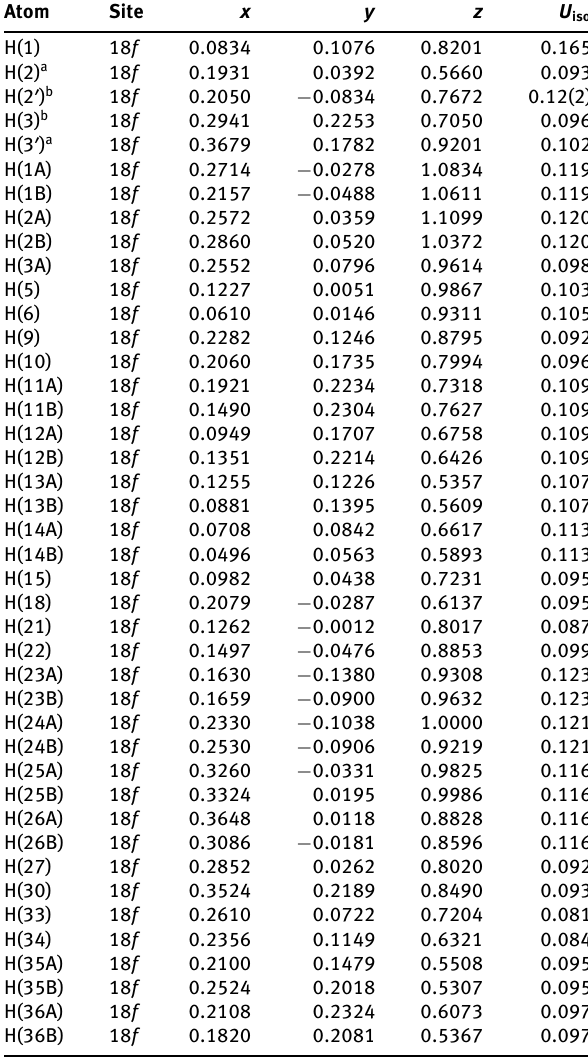
Table 2: Fractional atomic coordinates and isotropic or equivalent isotropic displacement parameters (Å 2